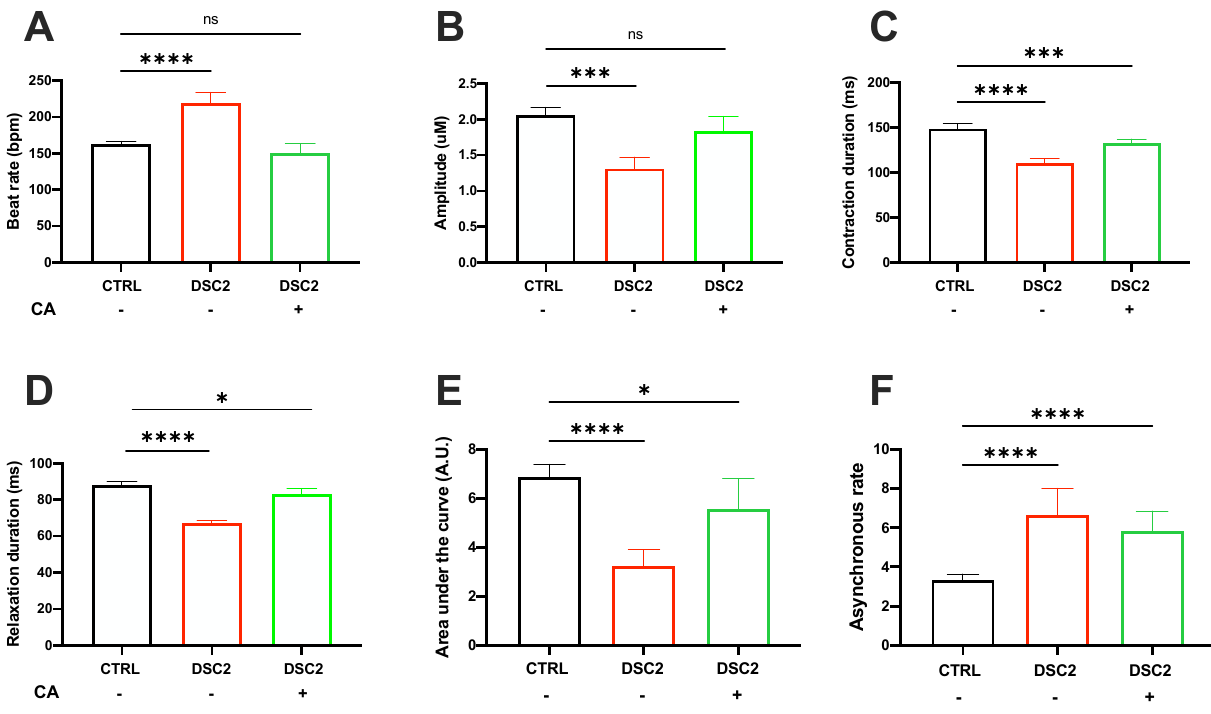
Figure 6. Effect of Canrenoic Acid on the Contractile Properties of hiPSC − CM. The contractile activity was studied by video analyses from a cell monolayer in control (black) ( n = 386),